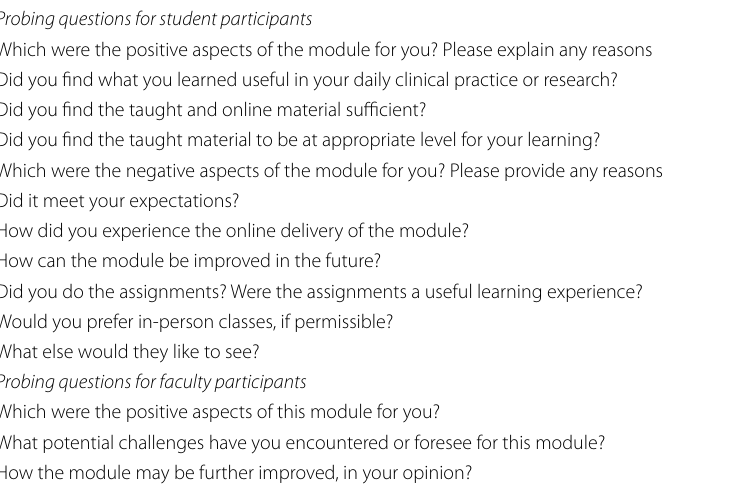
Table 2 Examples of probing questions Probing questions for student